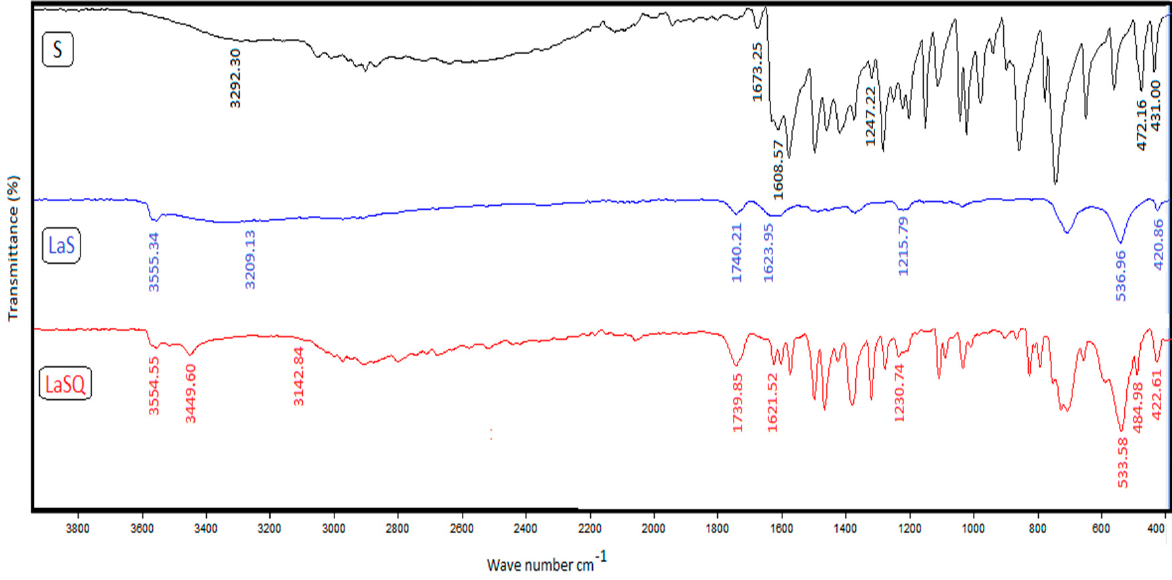
Table 3. FTIR spectral data in cm − 1 for salen and mixed-ligand salen/8-hydroxyquinoline metal complexes with Co(II), Ni(II), Cd(II), Al(III), and La(III). Compound